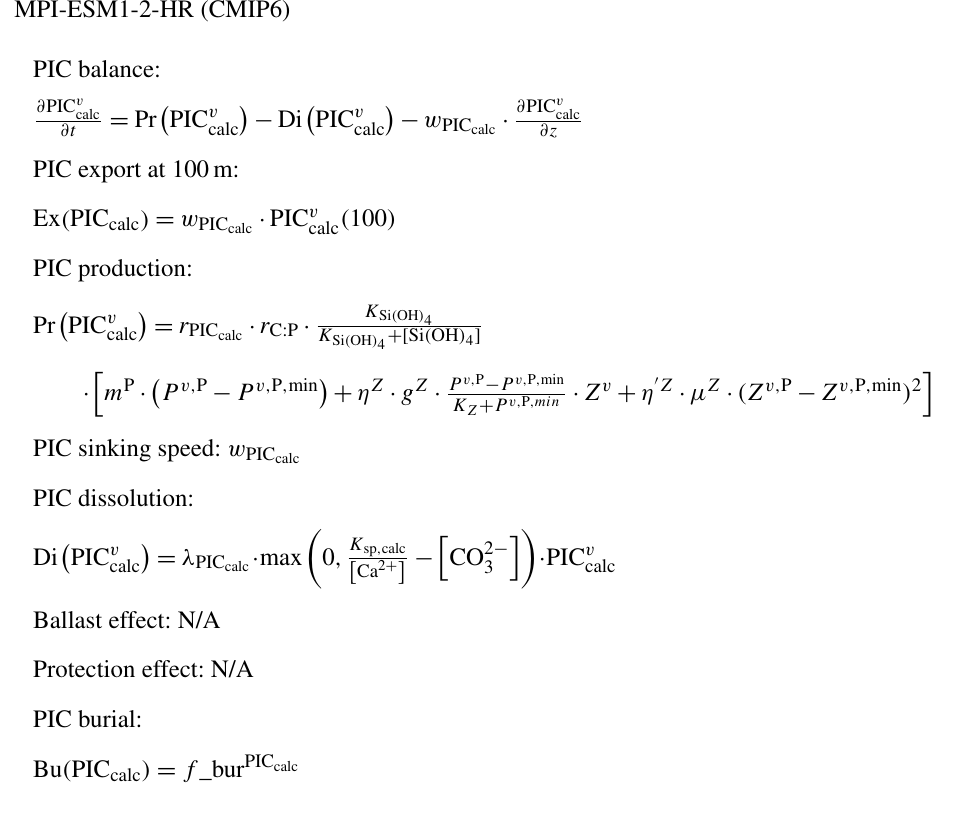
Table C12. HAMOCC5.2 and HAMOCC6